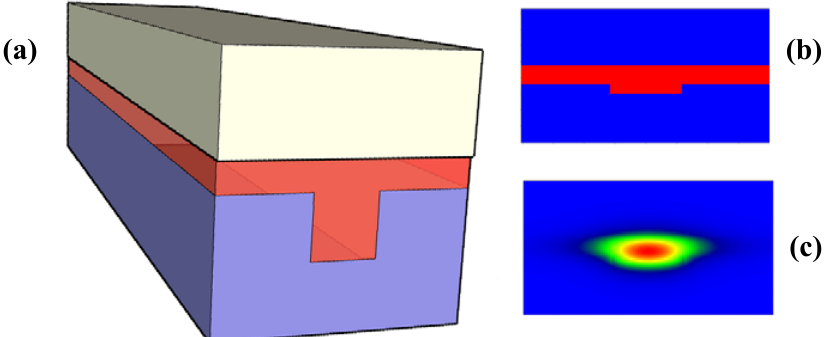
Figure 1. Three-layer polymer waveguide patterned with photolithography, the side view and the guided